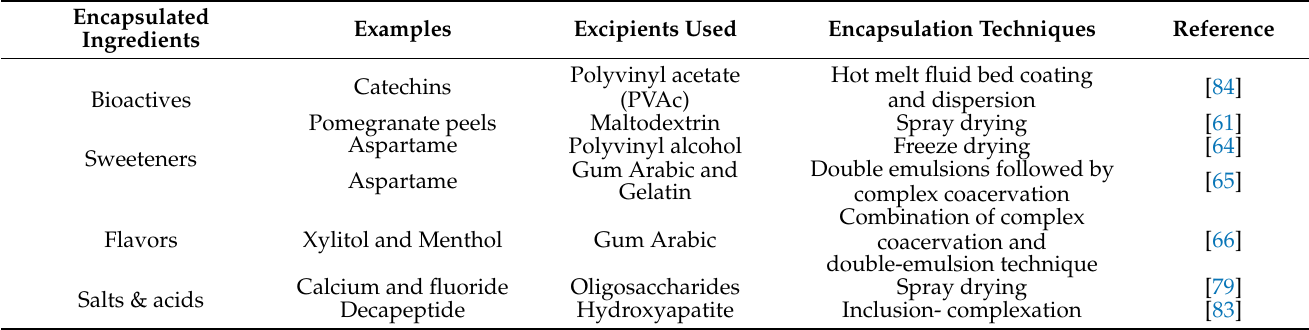
Table 2. Application of ingredients encapsulated in chewing